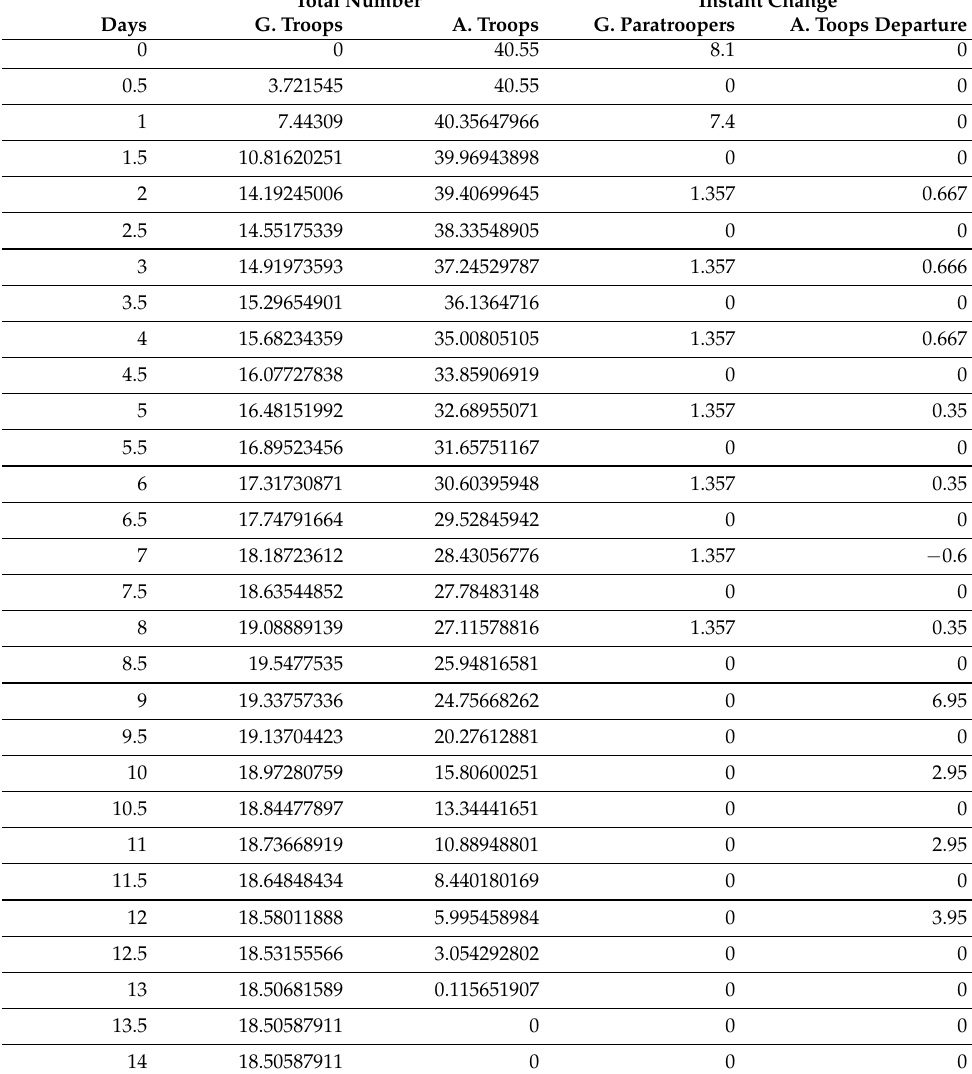
Table 2. Crete Battle dataset gathered from [28–31]. Data imputation was performed assuming Lanchester’s Square Law. Decimal notation is used dividing actual numbers by 1000. G and A stand for German and